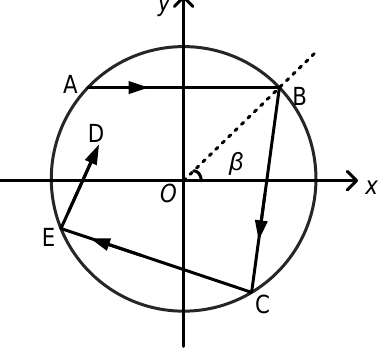
Figure 2. Projection of the propagation path of a skew ray on the cross section of an optical fiber.